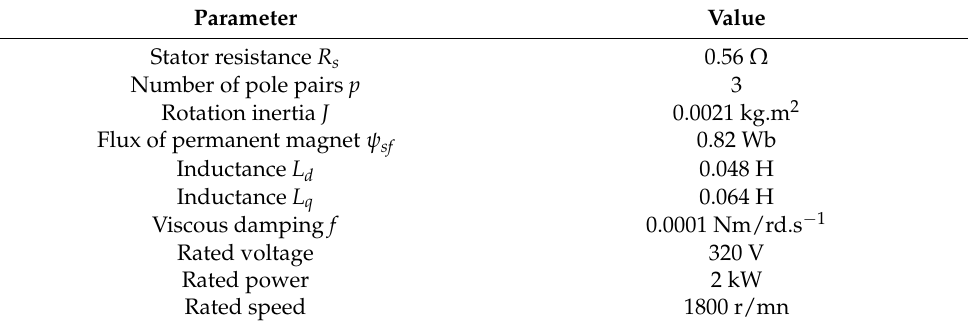
Table 1. Parameters of the controlled system.